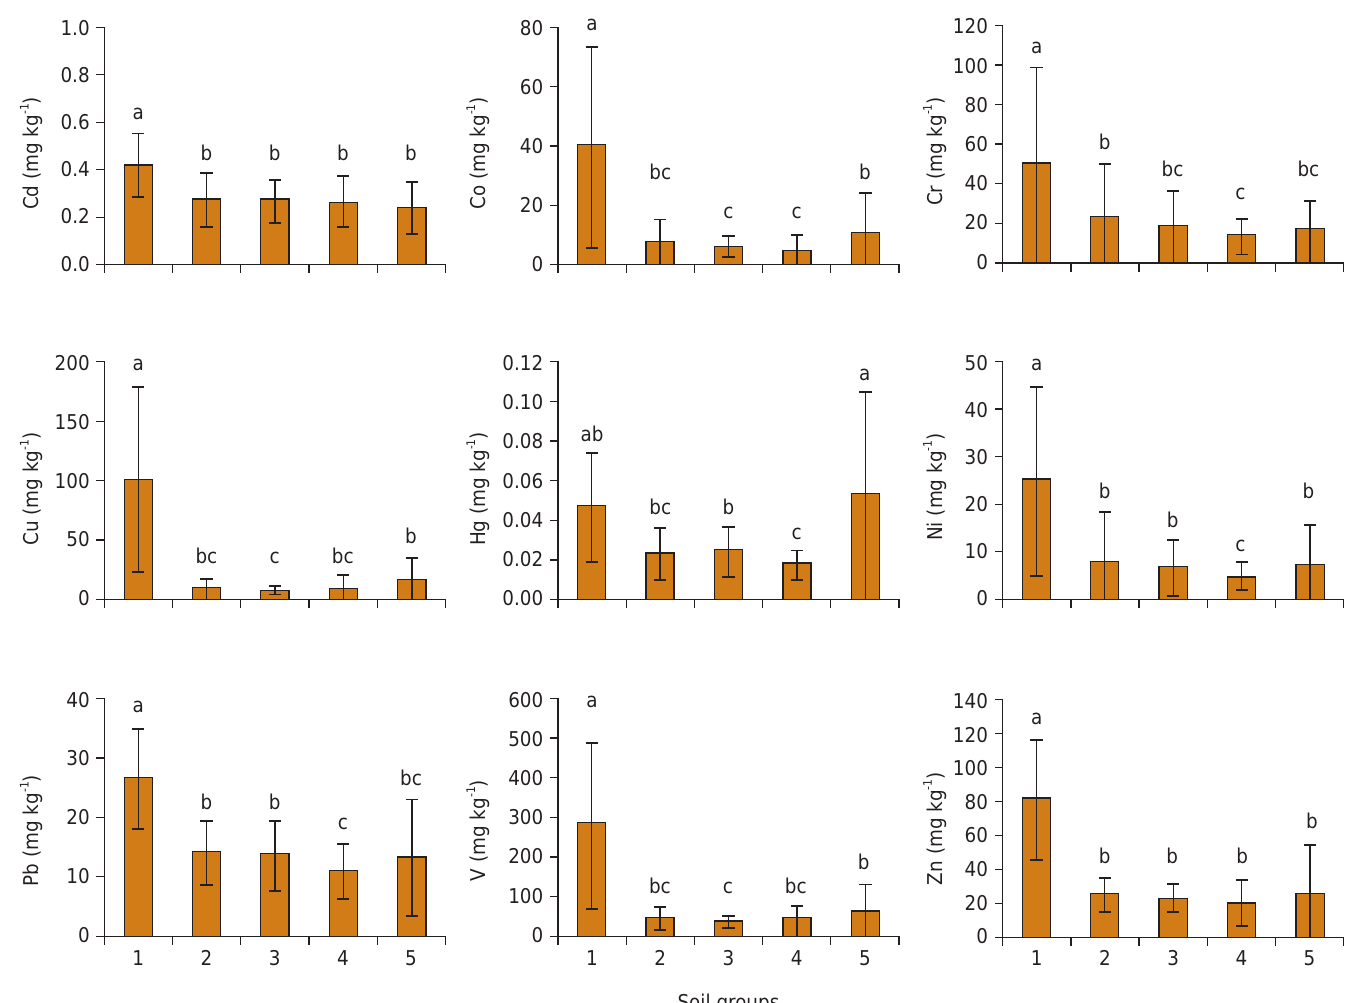
Figure 3. Average contents of semitotal Cd, Co, Cr, Cu, Hg, Ni, Pb, V, and Zn in the soil groups according to table 1. Averages with the same letters are not statistically different in the randomization test from Euclidean distance (p<0.05). Vertical bars indicate the standard